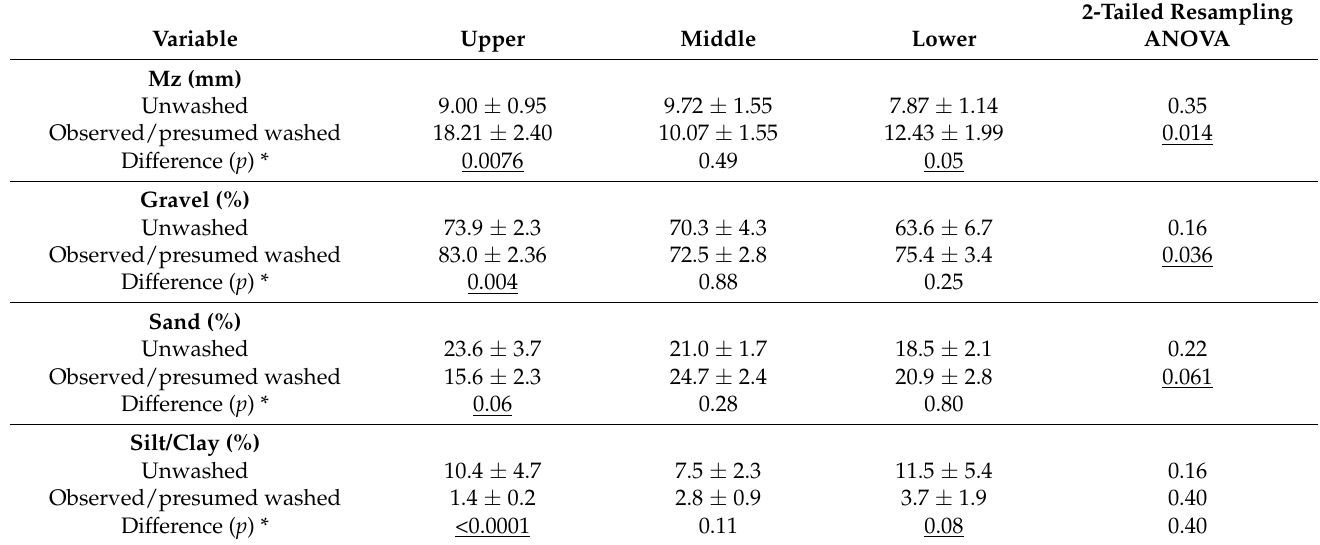
Table 6. Comparison of Mean Particle Size (Mz in mm), percent gravel, sand, and silt/clay in upper (0–5 cm), middle (5–10 cm), and lower (10–15 cm) horizons in bulk sediments from unwashed ( n = 15) and observed/presumed washed ( n = 23) sites sampled in Prince William Sound in June 2010. Third row for each variable presents the significance of the difference between unwashed and observed/presumed washed sites. Underlined p -values indicate significant differences.